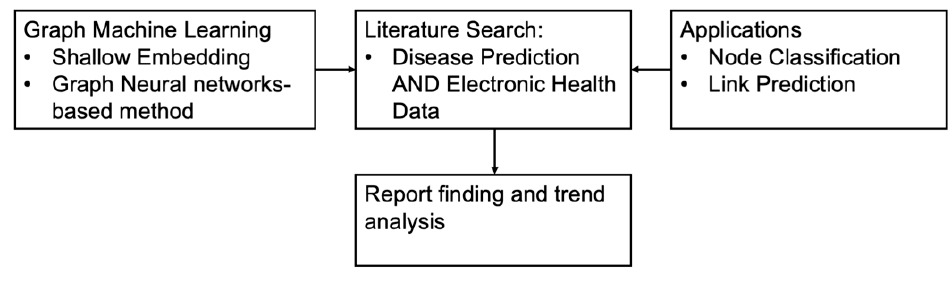
Figure 1. Overview of the study.